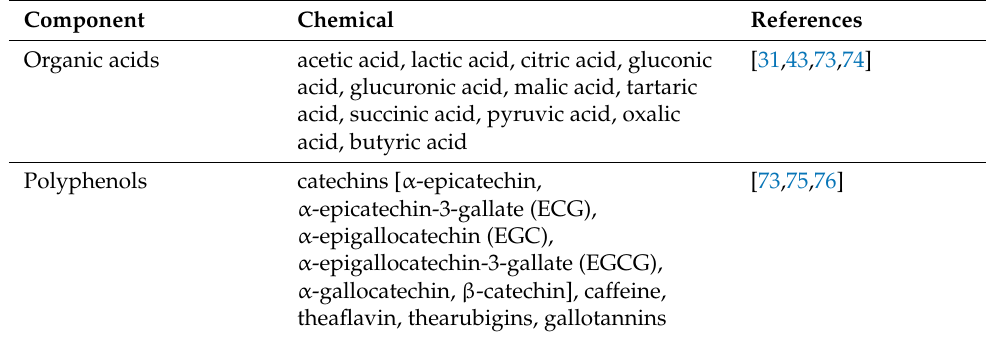
Table 2. Chemical compositions in kombucha